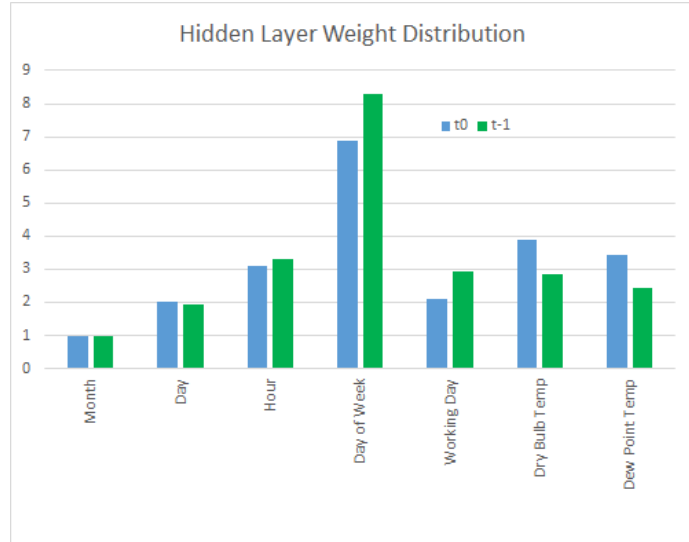
Figure 6. Synaptical weight